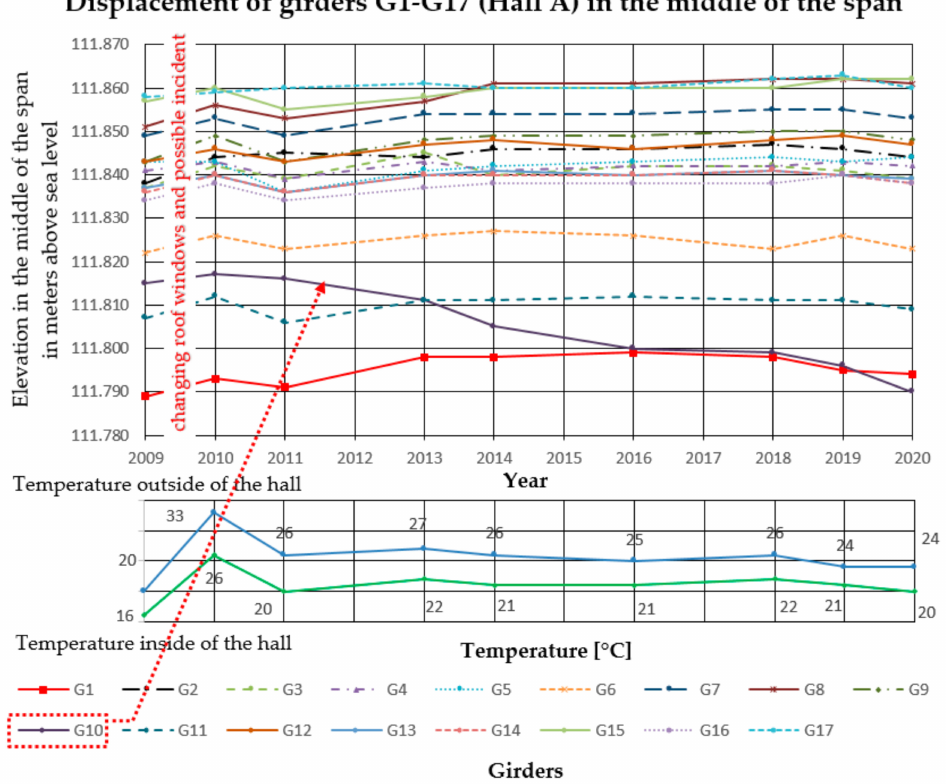
Figure 6. Displacement of girders in the middle of the span in Hall A. Visible significant change in the deflections of G10 girder detail shown in Figure